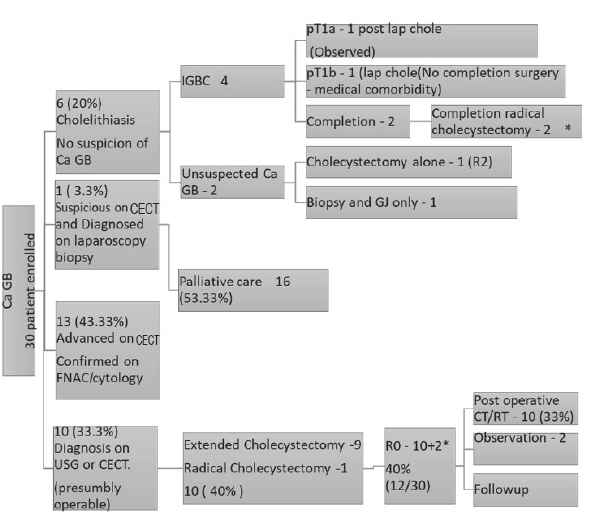
Figure 3: Flow chart of patient management